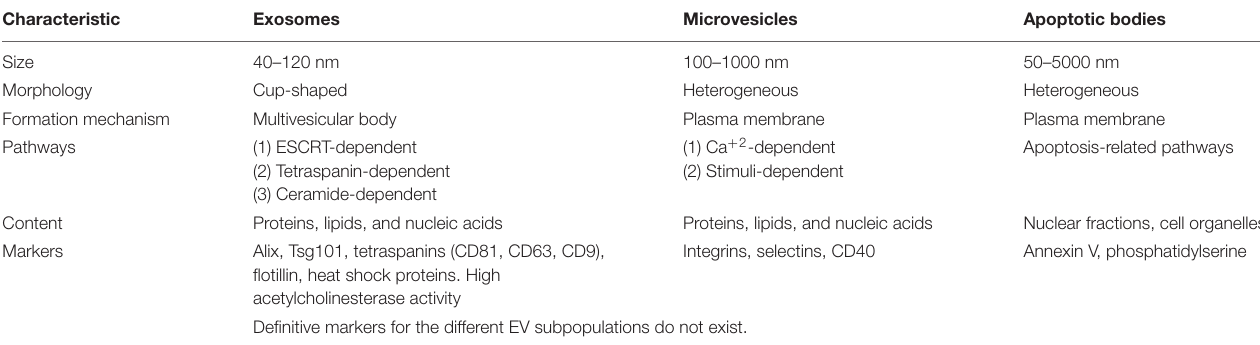
TABLE 1 | Types of extracellular vesicles based on their size and biogenesis